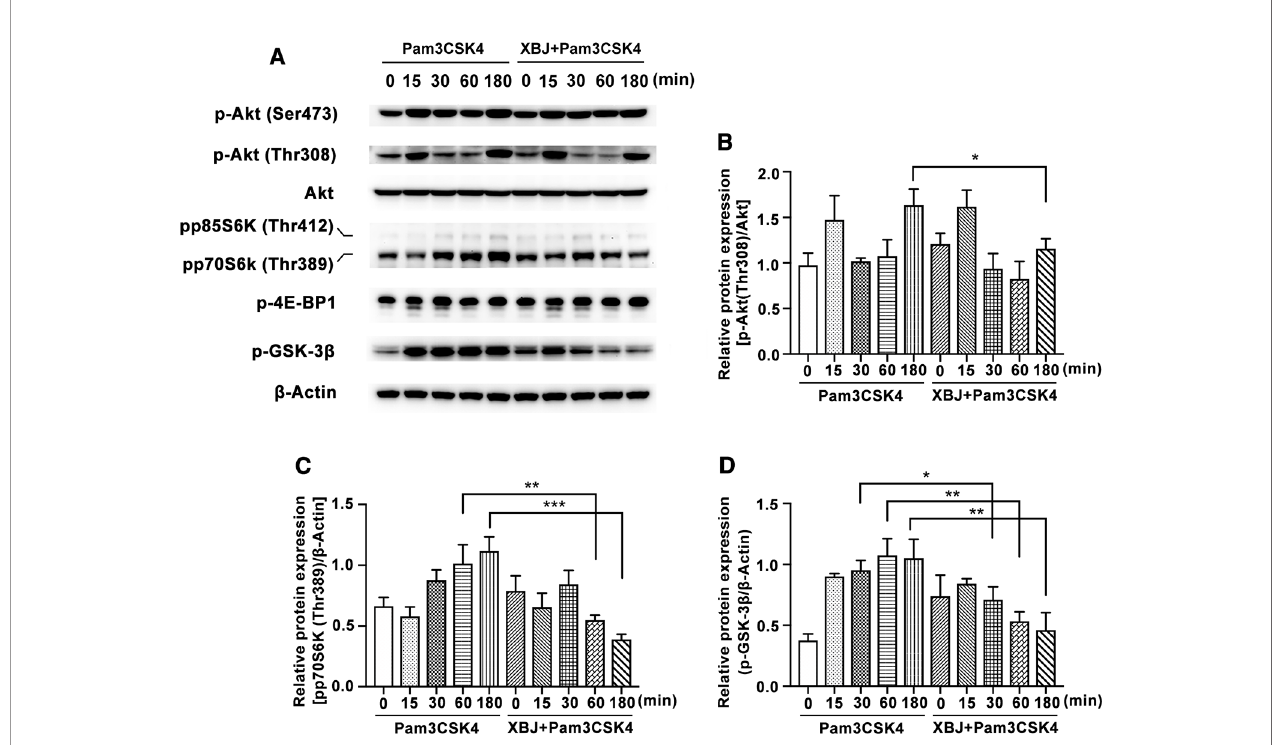
FIGURE 9 | XBJ inhibited Pam3CSK4-induced activation of PI3K/Akt pathway. Mouse primary peritoneal macrophages (1× 10 6 cells/well) were plated overnight, and then stimulated with Pam3CSK4 (100 ng/ml) in the presence or absence of XBJ (10 m l/ml) for different time periods. (A) The phosphorylation of signal proteins of PI3K/Akt pathway were examined by Western blot with the reference of total Akt and b -Actin. The bar graphs showed the statistical results for the relative quantitative expression of p-Akt (Thr308) (B) , pp70S6K (Thr389) (C) , and p-GSK-3 b (Ser9) (D) . Data were shown with the means ± SD of at least three independent experiments. * , ** , ***Signi fi cantly different at p < 0.05, p < 0.01, and p < 0.001,